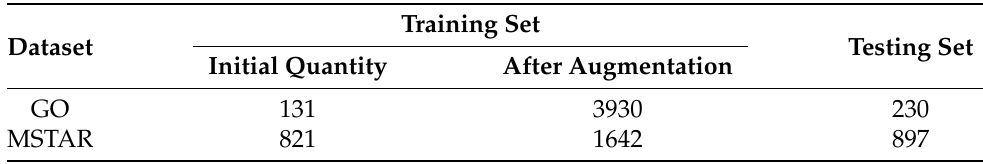
Table 2. The quantity of training images and testing